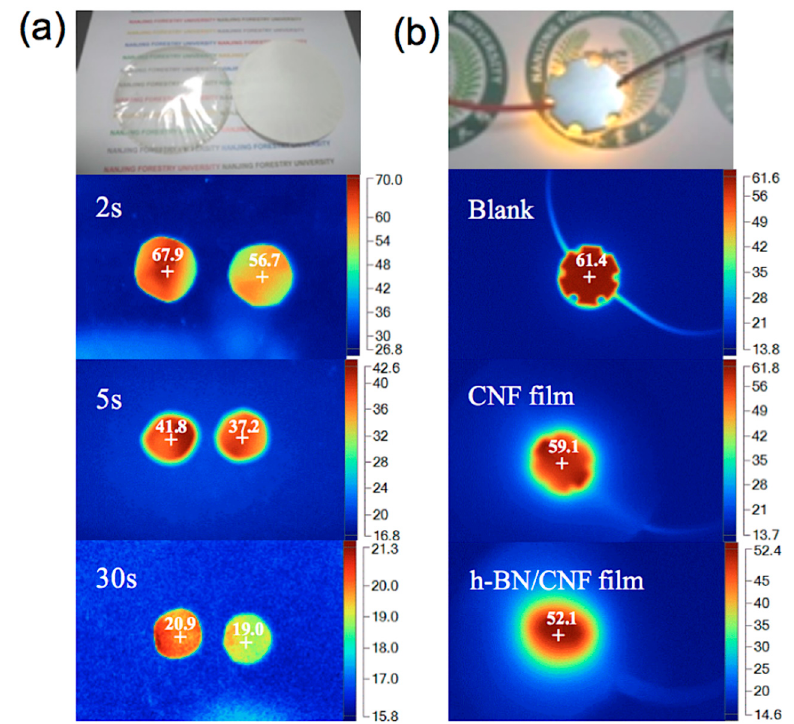
Figure 7. ( a ) Thermographs of pure CNF film and h-BN/CNF aerogel perfusion composite film with 23.08 wt % h-BN loading in cooling process. ( b ) Thermographs of pure CNF film and h-BN/CNF aerogel perfusion composite film with 23.08 wt % h-BN loading on the surface of a light-emitting diode (LED) luminescence chip.